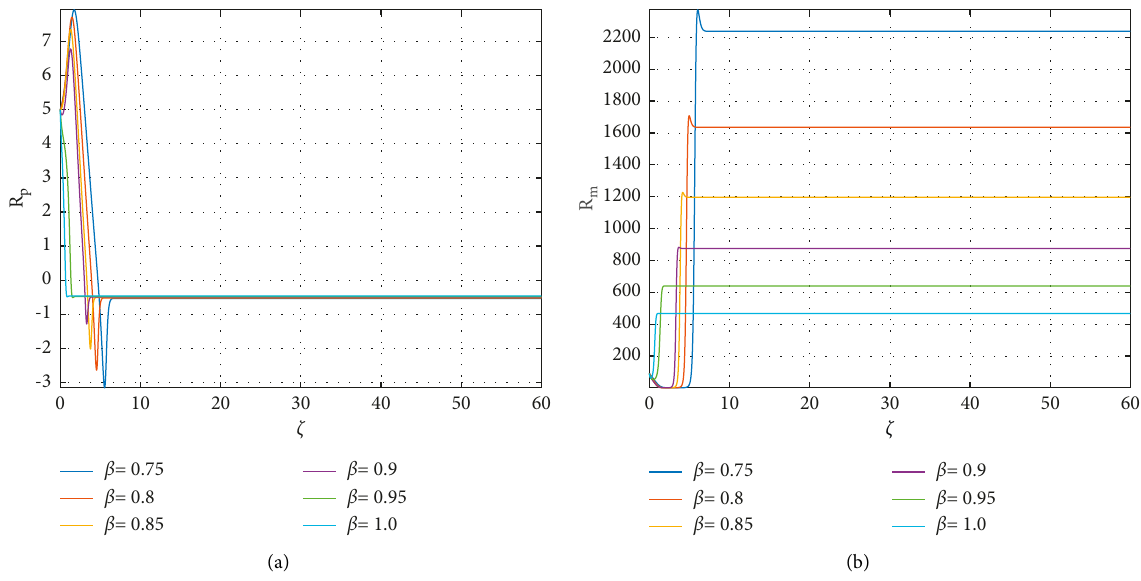
Figure 6: Two-dimensional illustration of the pneumonia recovered R orders β ∈ [ 0 , 1 ] .